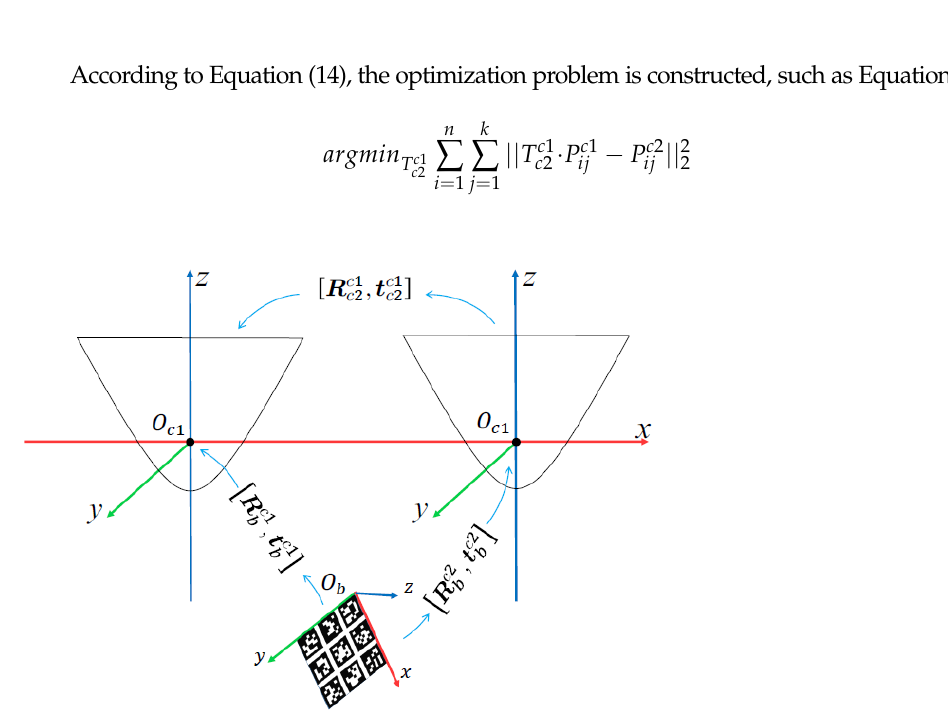
Figure 14. Coordinate systems relationship of binocular stereo panoramic calibration.